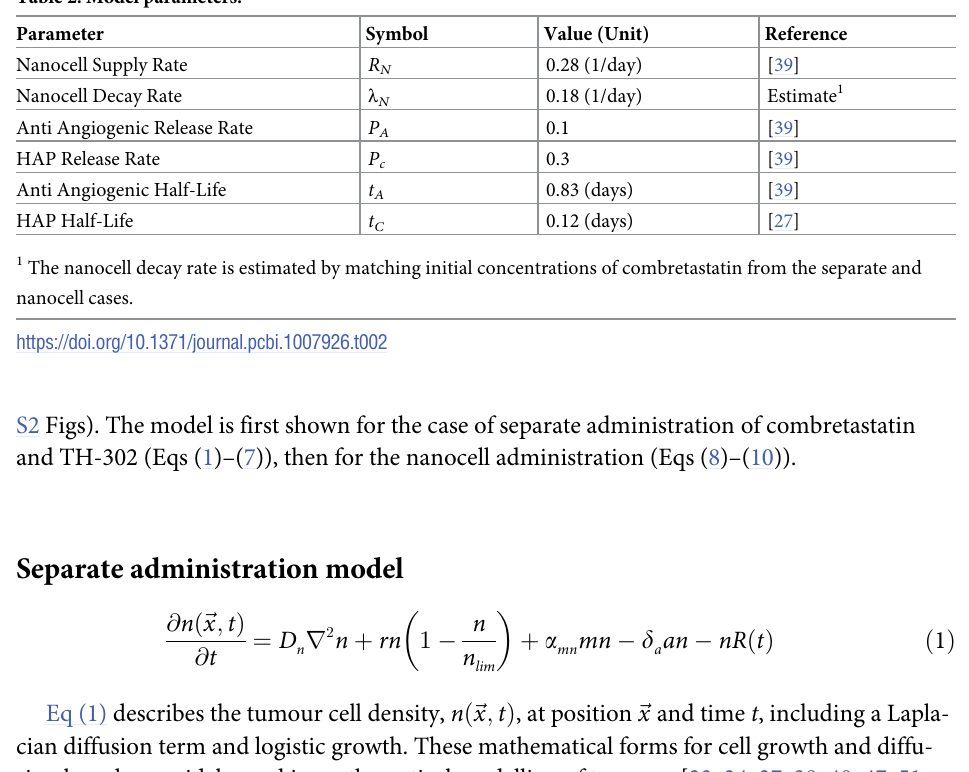
Table 2. Model parameters.